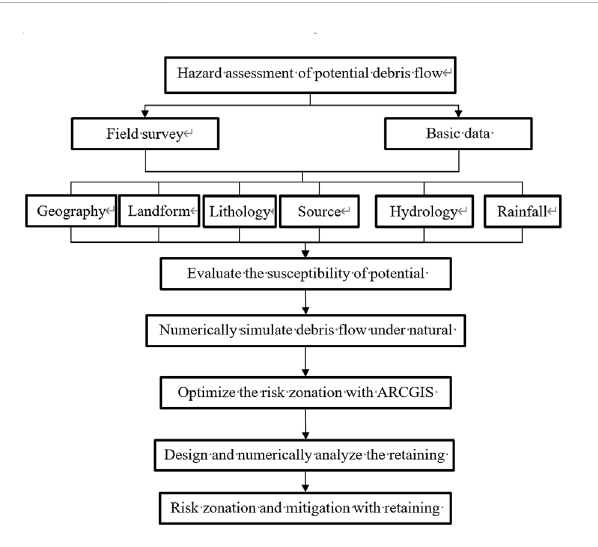
FIGURE 2 Flowchart of Hazard assessment of potential debris fl